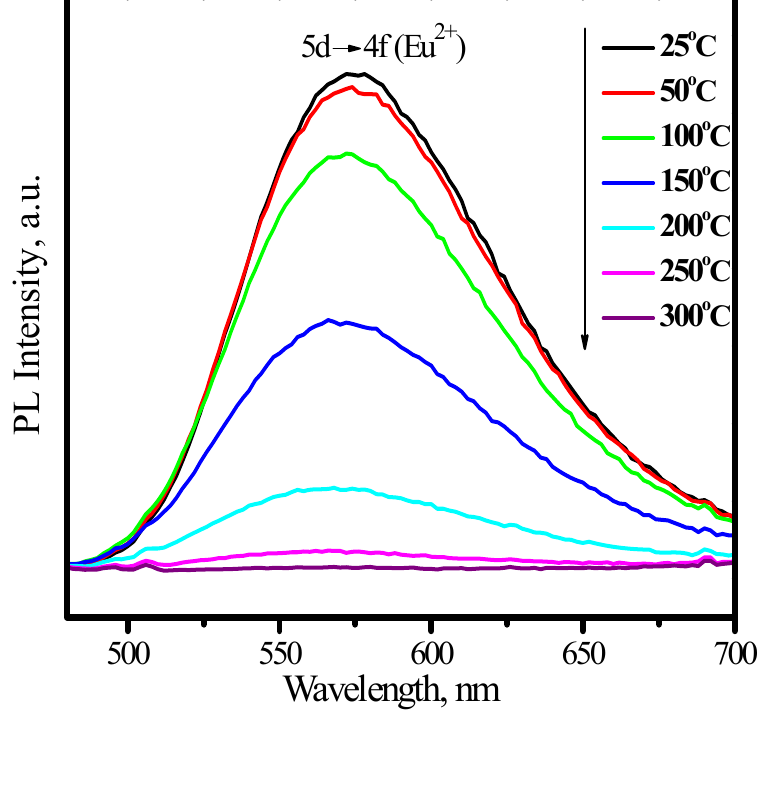
Figure 10. Emission spectra of (Sr different